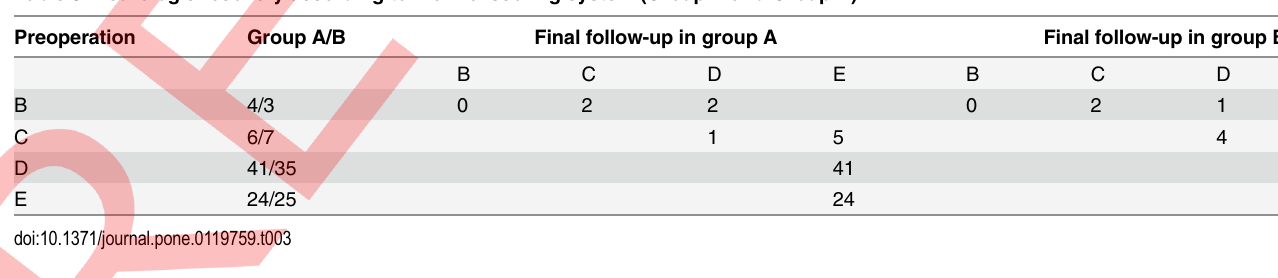
Table 3. Neurologic recovery according to Frankel scoring system (Group A and Group